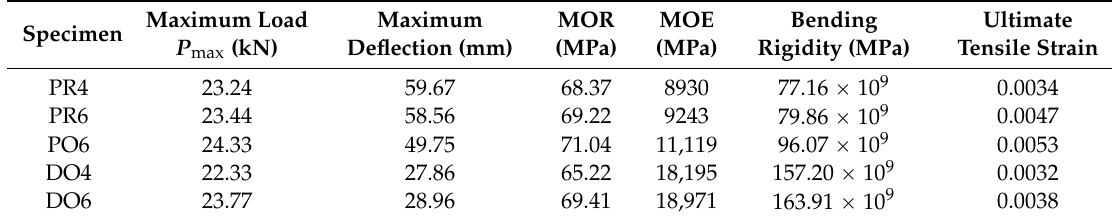
Table 3. Experimental results of each series.